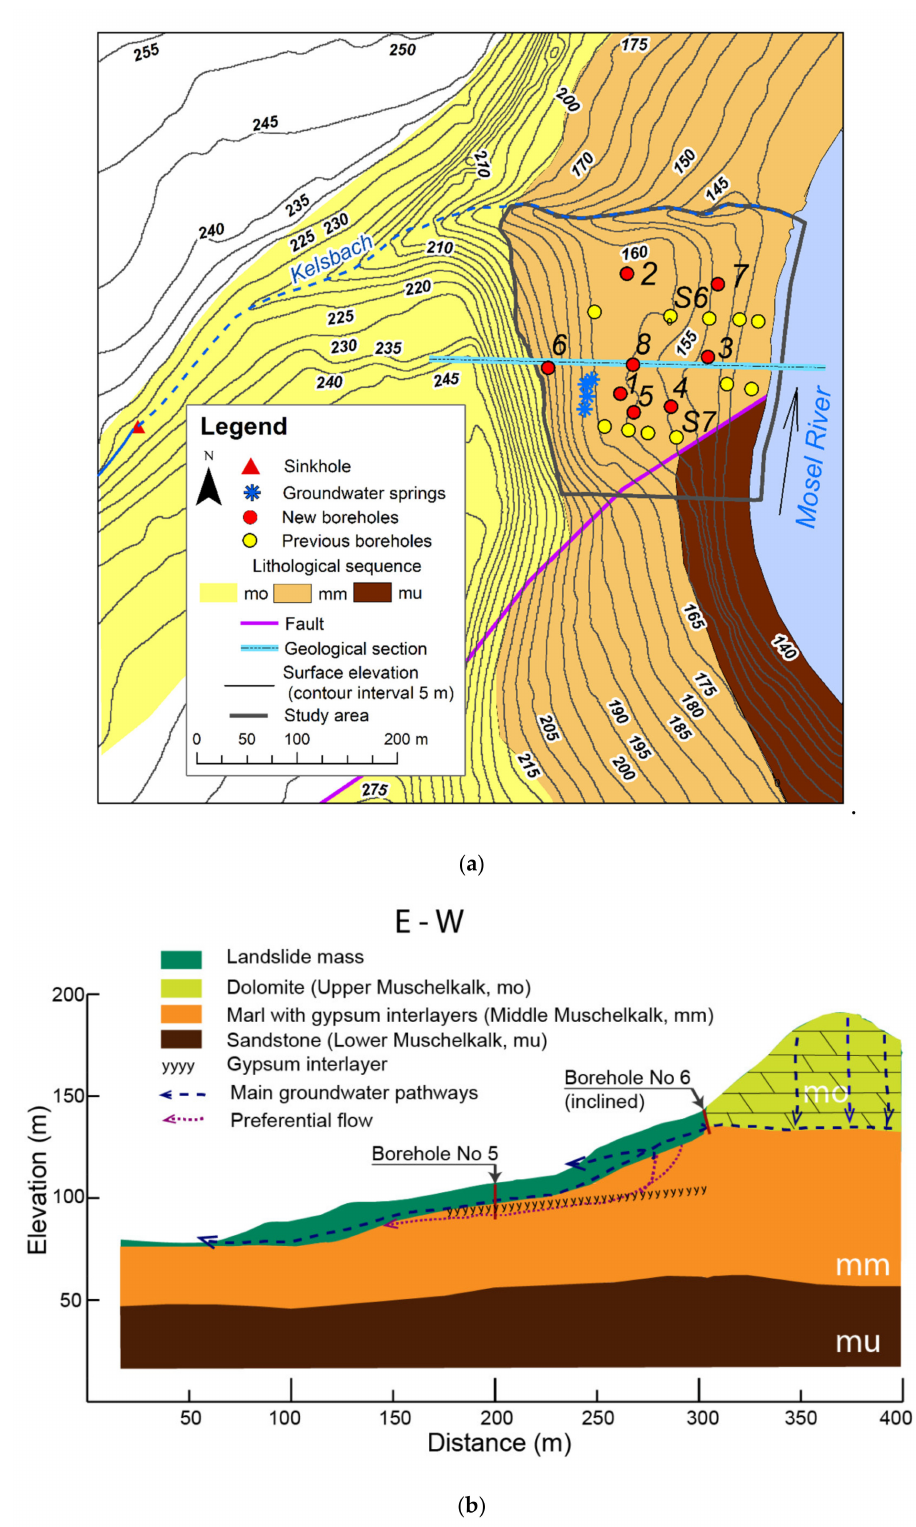
Figure 2. ( a ) Geological sketch of the landslide area showing distribution of boreholes and groundwa- ter springs ( b ) geological section of the area showing conceptual hydrogeological settings (processed from